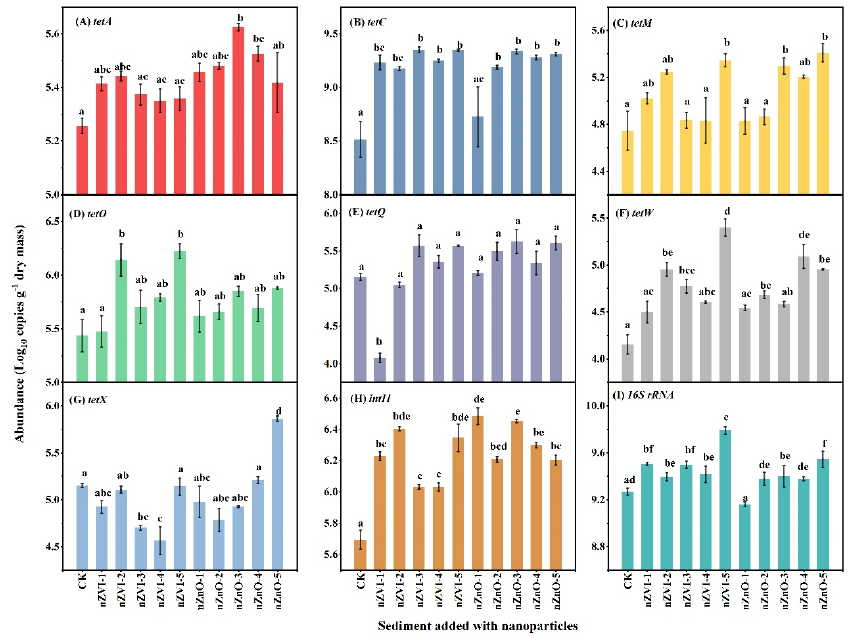
Figure 1. Effect of nanoparticles on the abundance of ( A ) tetA , ( B ) tetC , ( C ) tetM , ( D ) tetO , ( E ) tetQ , ( F ) tetW , ( G ) tet X, ( H ) intI1 and ( I ) 16S rRNA in sediment under microcosm incubation (scenario 1). The different letter indicates p < 0.05.